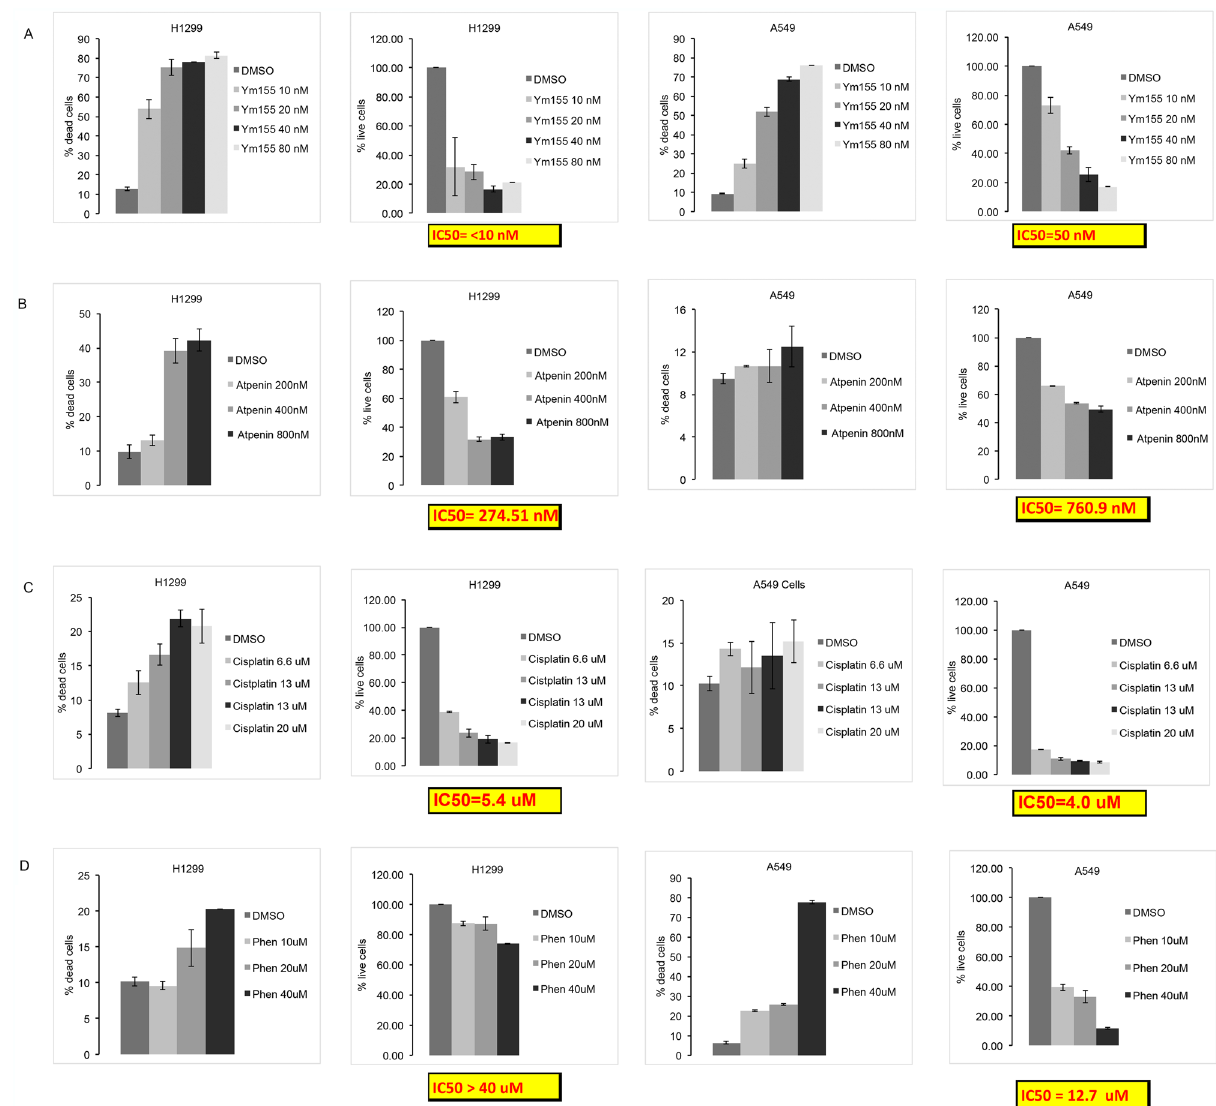
Figure 8. Ym155 is more potent suppressing growth and inducing cell death compared to other mitochondrial inhibitors. H1299 and A549 cells were treated with inhibitor for 48 h. and the percent live and dead cells counted. The data represents the represents mean of 2 experiments treated with ( A ) Ym155, ( B ) Atpenin, ( C ) cisplatin, ( D ) or